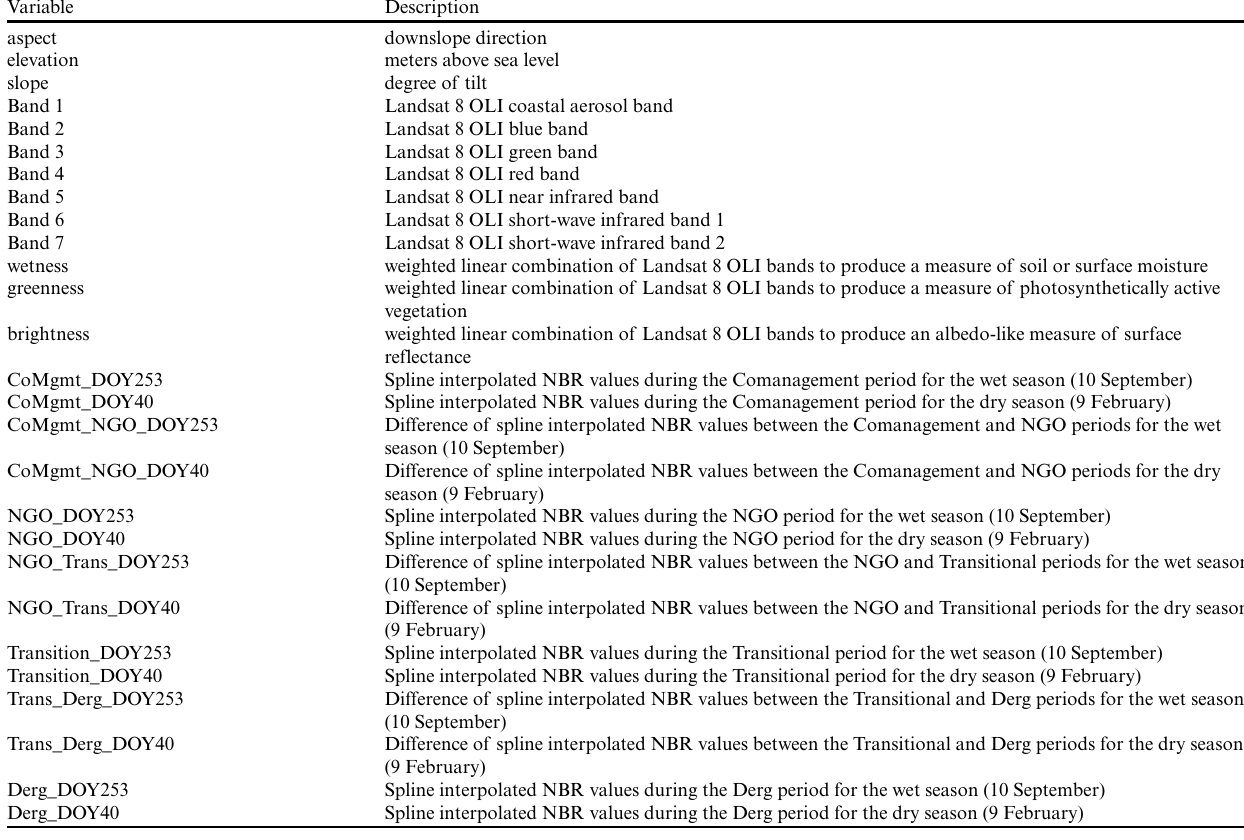
Table 1 . Description of 27 predictor variables used in the supervised classification. Variable